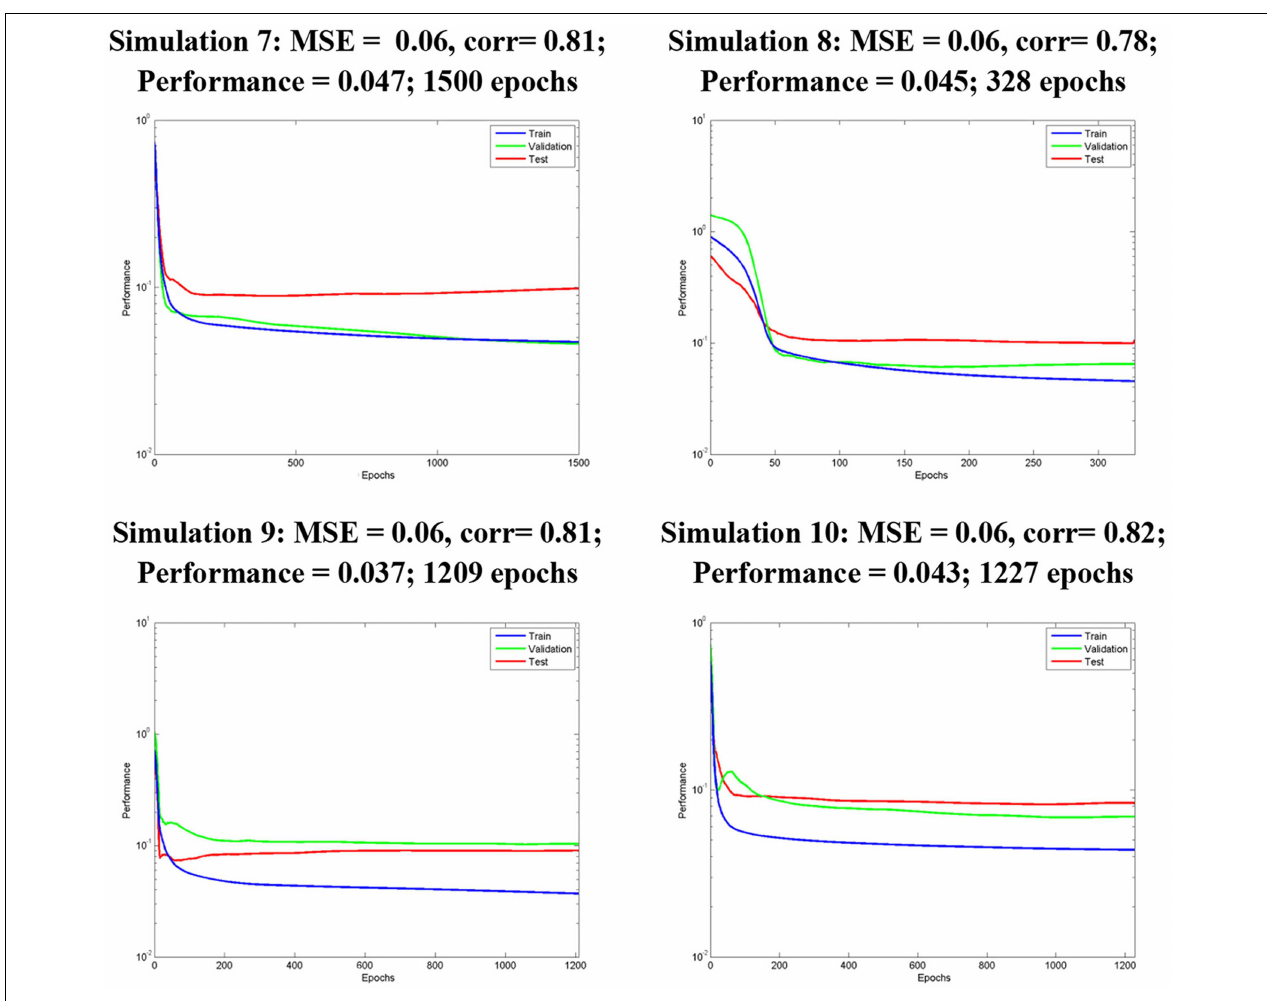
FIGURE 7 | Simulations of the ANN model during the present climate period (1963–2003). In y-axis is the performance of each simulation divided in train (blue line), validation (green line), and test (red line) during different epochs